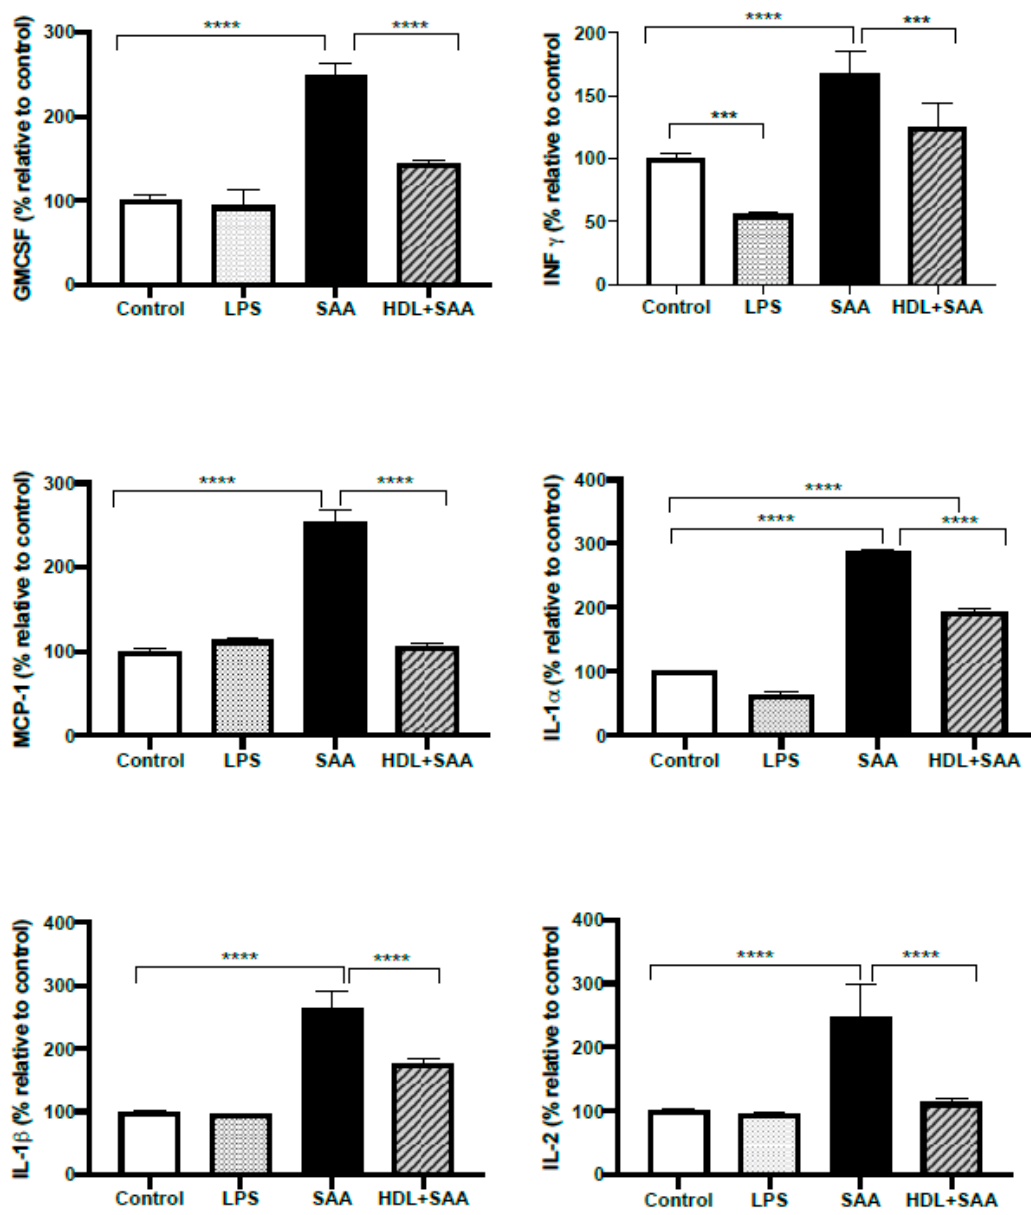
Figure 10. Selected cytokine levels (IL- 1 α , IL-1 β , IL-2, MCP-1, IFN- γ and GM-CSF) in kidney tissue from young cohort of ApoE − / − mice following SAA and HDL treatments. Mice were allocated into 4 treatments arms and administered with vehicle (control), LPS, SAA alone, or SAA in combination with HDL. Renal tissue was harvested 4 weeks after commencement of SAA treatment, processed, and cytokines were measured by ELISA / multiplex assay in tissue homogenates, as described in the methods section. Data represent percentage change with respect to the control group (maximal SAA-stimulated values for cytokine / chemokine tested were (ng / ml): IL-1 α , 21.3; IL-1 β , 27.1; IL-2, 28.3; MCP-1, 25.1; INF γ , 26.1; GMCSF, 26.9). Data shows mean ± SD with mice numbers were control ( n = 7), LPS ( n = 8), SAA ( n = 6), and HDL / SAA ( n = 6). Di ff erent to the control, *** p < 0.001, **** p < 0.0001. Di ff erent to the respective SAA and HDL / SAA group, # p < 0.05, ## p < 0.01.